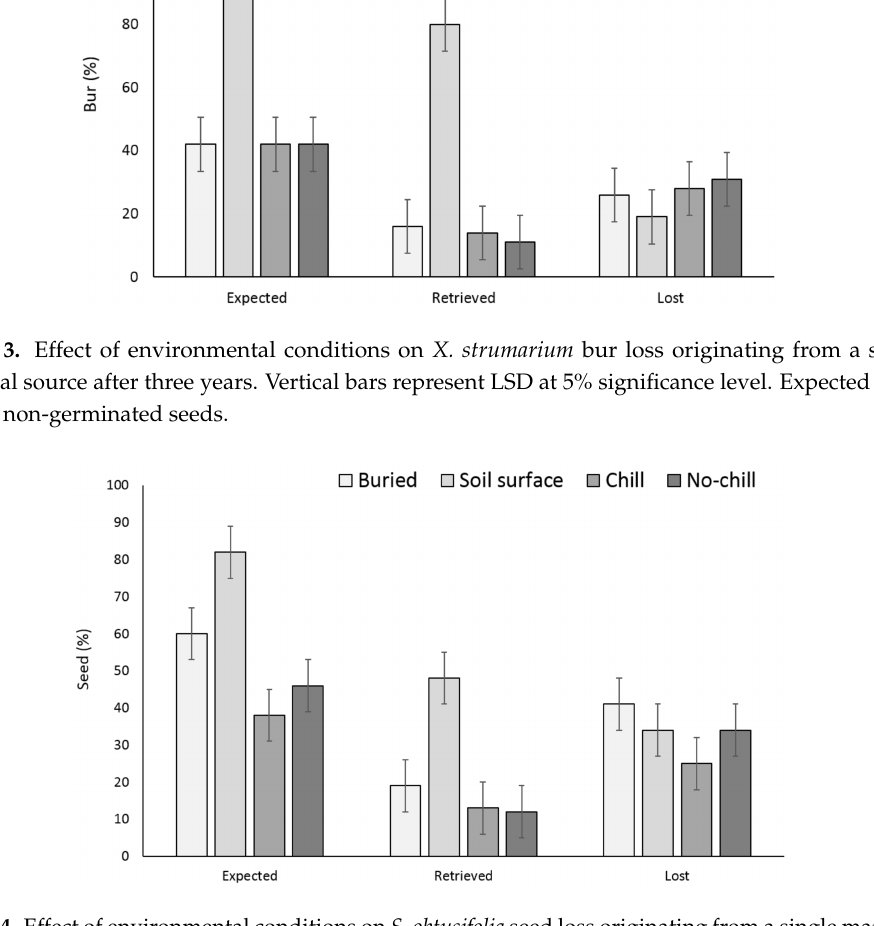
Figure 4. Effect of environmental conditions on S. obtusifolia seed loss originating from a single maternal source after three years. Vertical bars represent LSD at 5% significance level. Expected is the sum of non-germinated seeds. Table 1. Percentage germination of S. obtusifolia seeds from single maternal source under various environmental